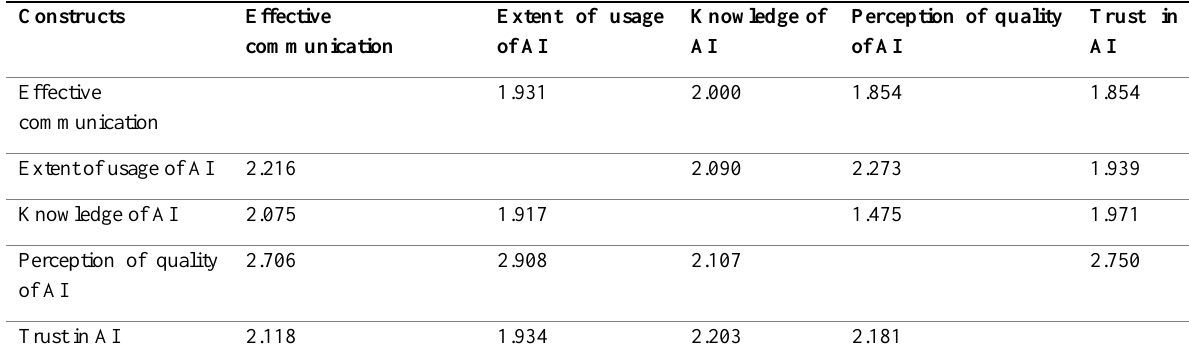
Table 7: Common Method Bias